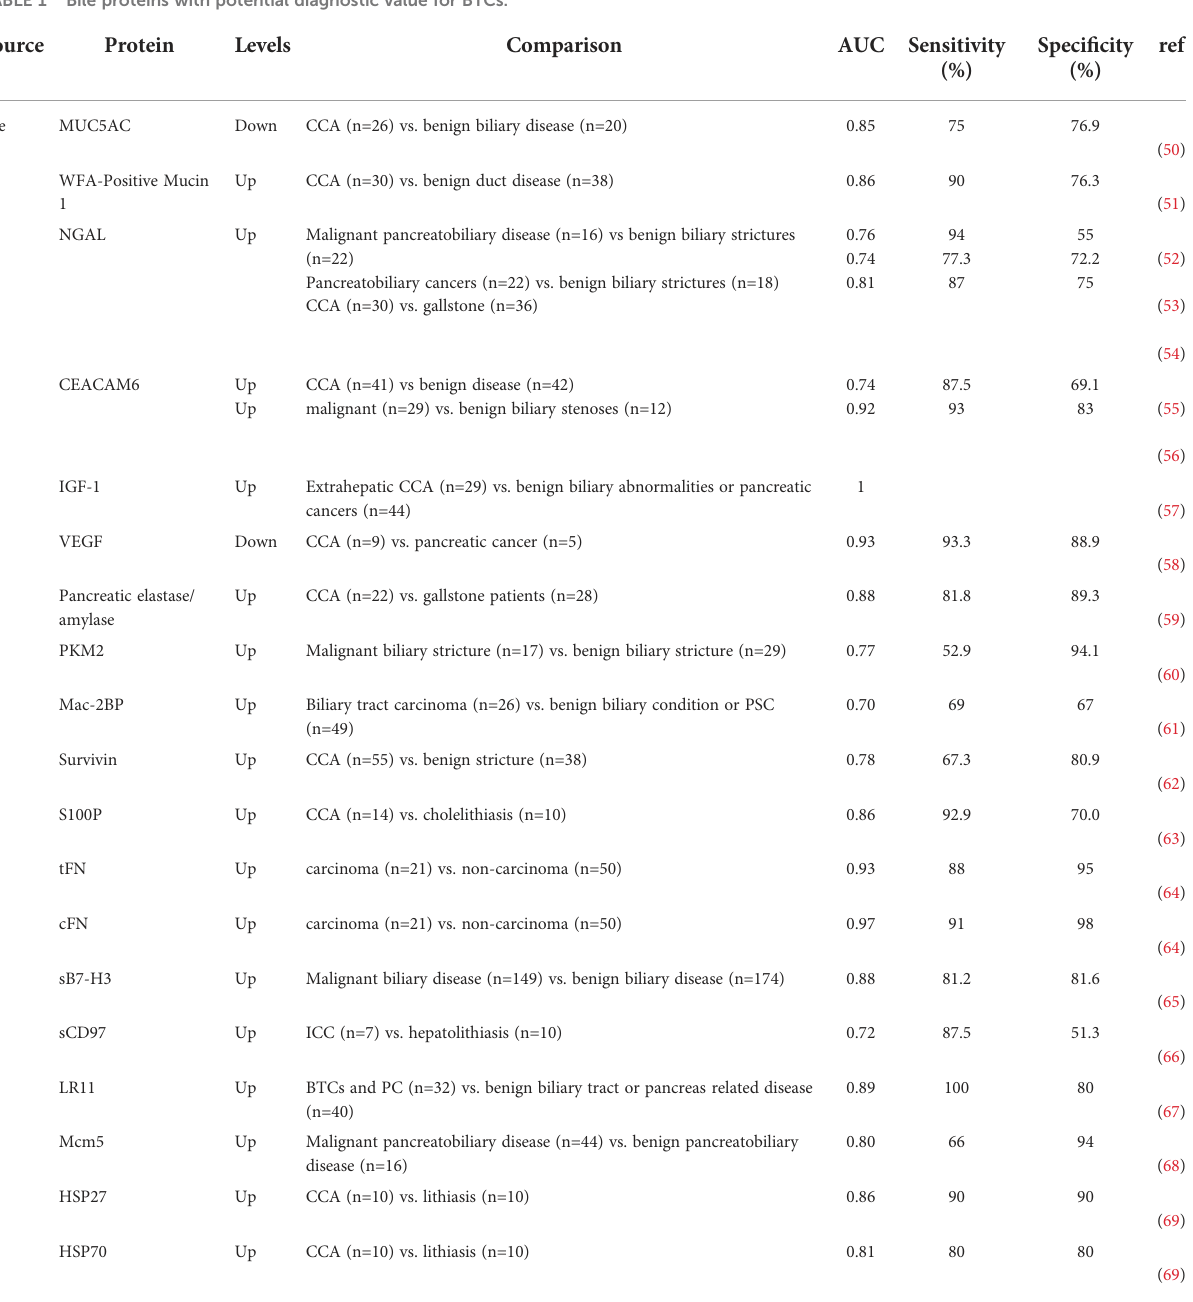
TABLE 1 Bile proteins with potential diagnostic value for